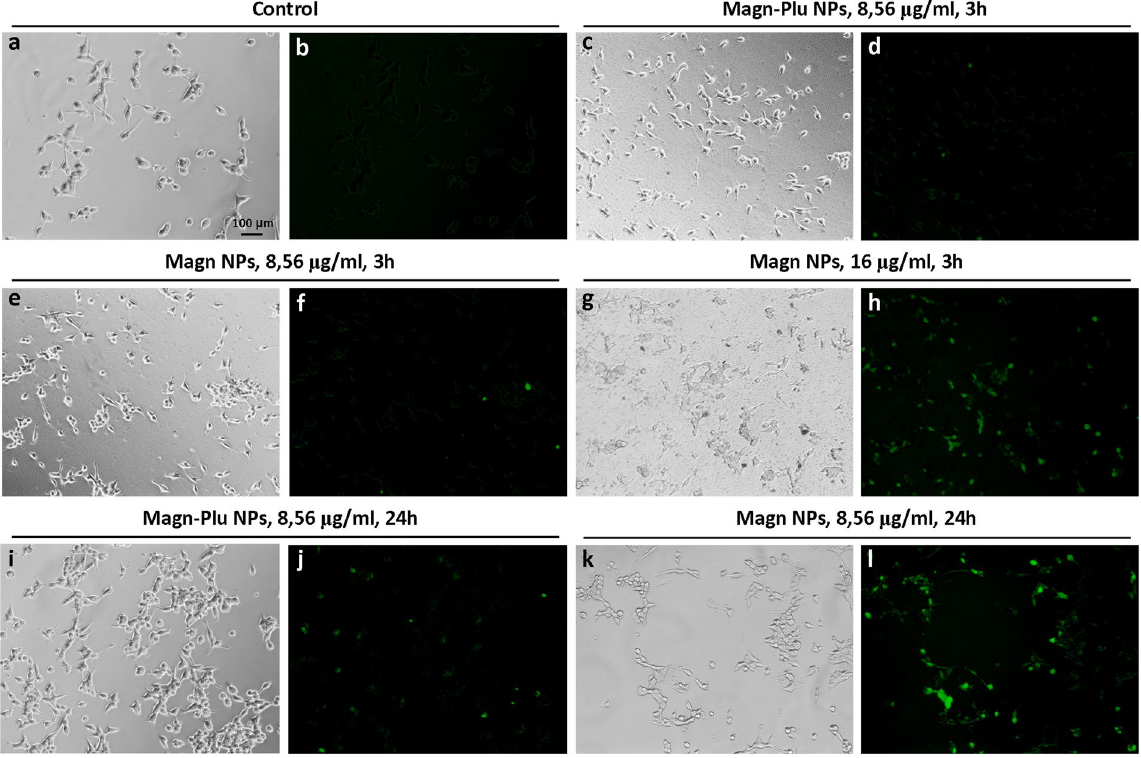
Figure 8. Intravital H2DCFDA staining of LNCaP cells incubated with Magn-Plu and Magn NPs during 3 and 24 h. ( a,c,e,g,i,k ) – phase contrast microscopy; ( b,d,f,h,j,l ) – fluorescent microscopy.